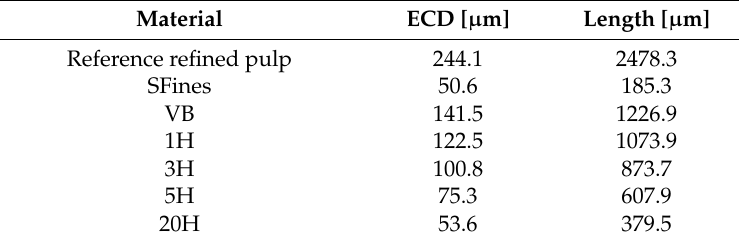
Table 2. Average values of Equivalent Circular Diameter (ECD) and Length (weight weighted) obtained for refined pulp and each fine cellulosic materials. The values were calculated from the distributions of the three measurements realized per material, using L&W Fiber